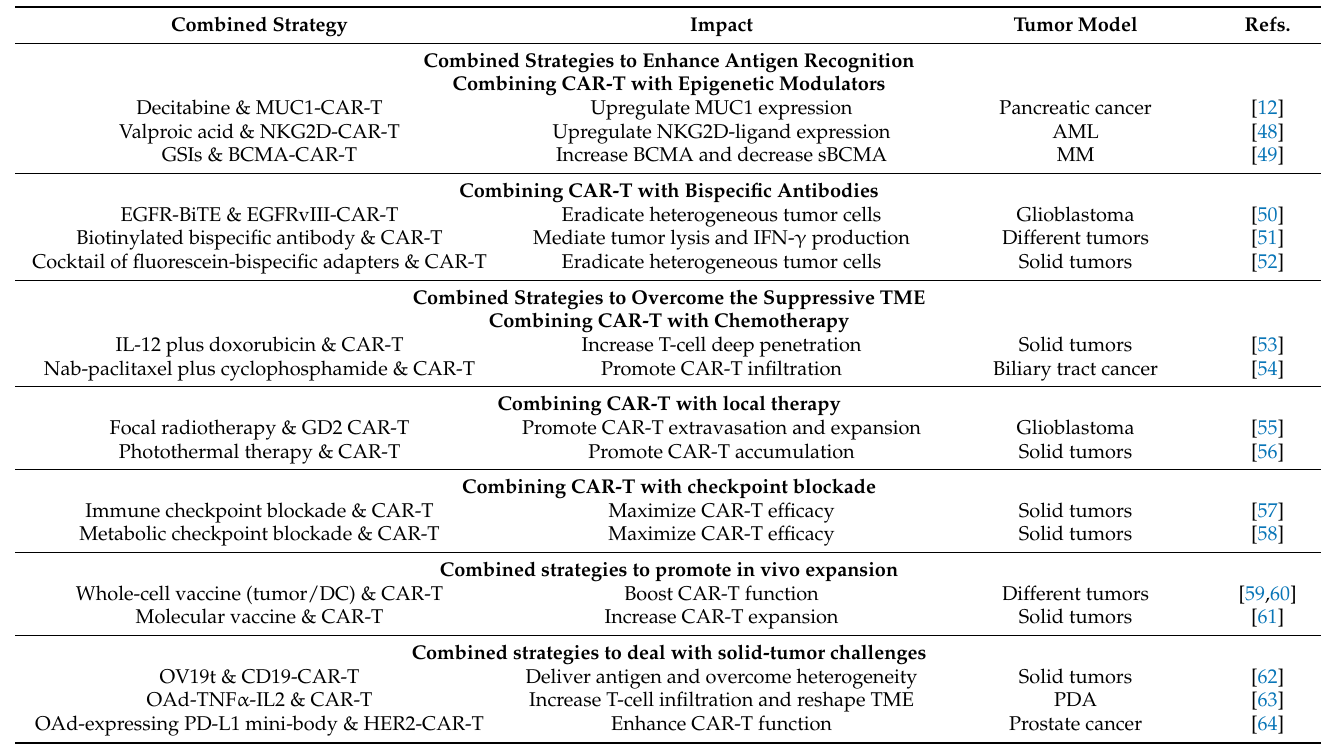
Table 1. Combined strategies to enhance CAR-T function. CAR—Chimeric antigen receptor; MUC1—Mucin 1; NKG2D— Natural killer group 2 member D; AML—Acute myeloid leukemia; BCMA—B cell maturation antigen; sBCMA—Soluble B cell maturation antigen; MM—Multiple myeloma; BiTE—Bispecific T cell engager; EGFR—Epidermal growth factor receptor; IFN- γ —Interferon- γ ; IL—Interleukin; DC—Dendritic cell; CD—Cluster of differentiation; OV—Oncolytic virus; OV19t— Truncated CD19t protein; TNF- α —Tumor necrosis factor- α ; PDA—Pancreatic ductal adenocarcinoma;